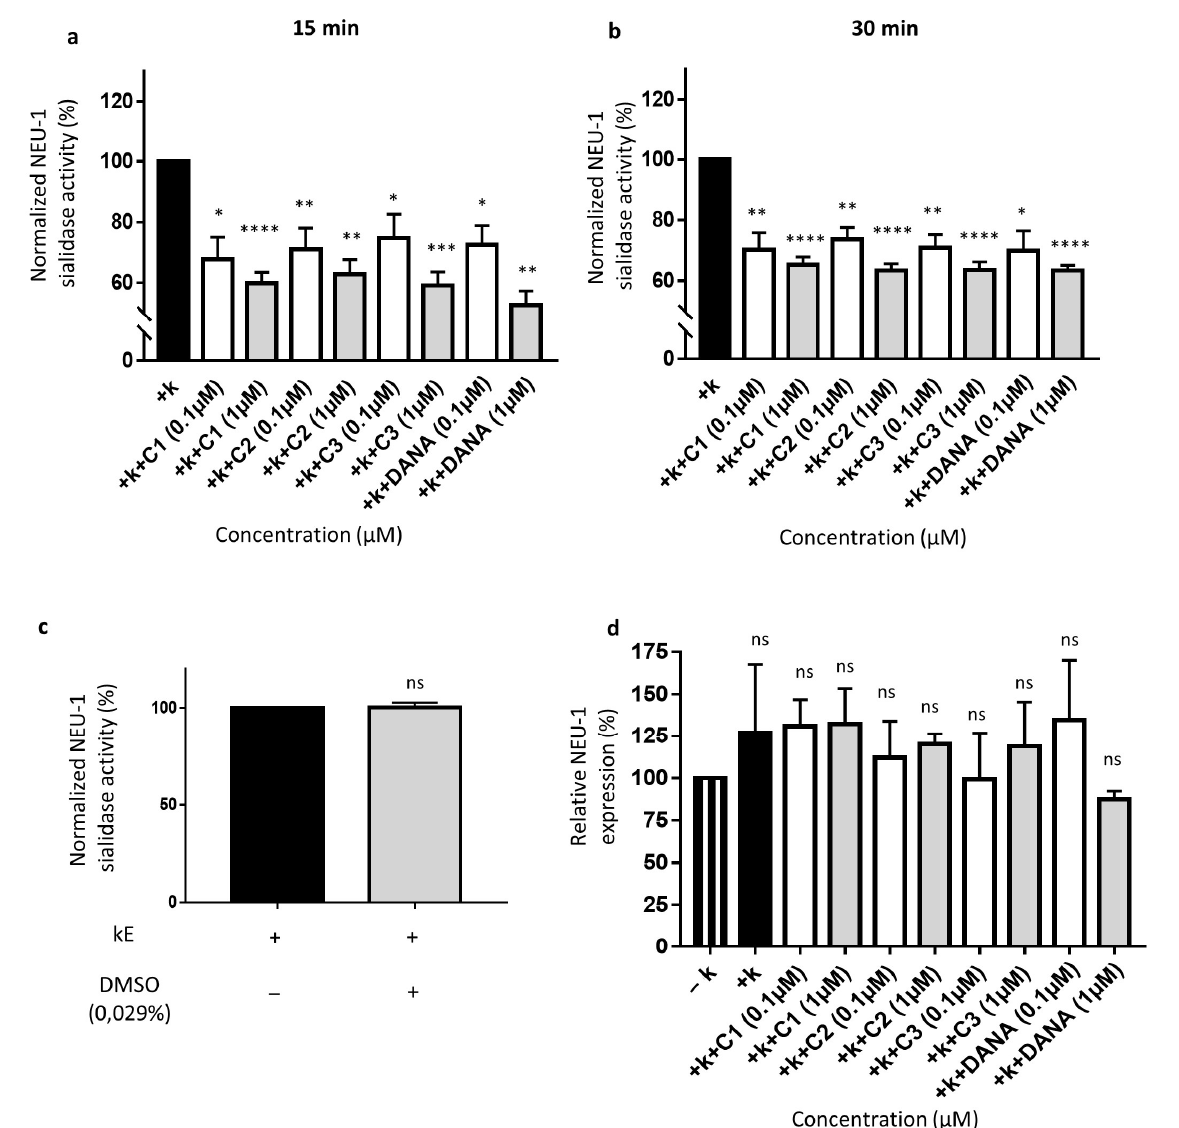
Figure 4. Effects of N-Acetyl-2,3-dehydro-2-deoxyneuraminic acid and compounds 1 – 3 on membrane NEU-1 sialidase activity in full adherent macrophages. Adherent macrophages were incubated with DANA and the vegetal compounds and sialidase activity was triggered or not by к -elastin. ( a ) Normalized membrane NEU-1 sialidase activity after 15 min incubation with DANA or compounds 1 – 3 at 0.1 or 1 µM under к -elastin stimulation ( n = 3–6) ( t test). ( b ) Normalized membrane NEU-1 sialidase activity after 30 min incubation with DANA or compounds 1 – 3 at 0.1 or 1 µM under к -elastin stimulation.%. ( n = 3–8) ( t test). Results are represented compared to the control condition (+ к -elastin) normalized to 100%. ( c ) Effects of DMSO alone on membrane NEU-1 sialidase activity under к -elastin stimulation ( n = 4) ( t test). ( d ) Relative NEU-1 expression in presence of the vegetal compounds and DANA at 0.1 and 1 µM. The expression of NEU-1 was normalized to β -actin ( n = 3), (ANOVA) (C1: feddeiketone B, C2: 2,3-Dihydroxy-1-(4-hydroxy-3,5-dimethoxyphenyl)-1-propanone, C3: syringylglycerol, DANA: N-Acetyl-2,3-dehydro-2-deoxyneuraminic acid), (ns: non-significant, * p < 0.05, ** p < 0.01, *** p < 0.001, **** p < 0.0001).